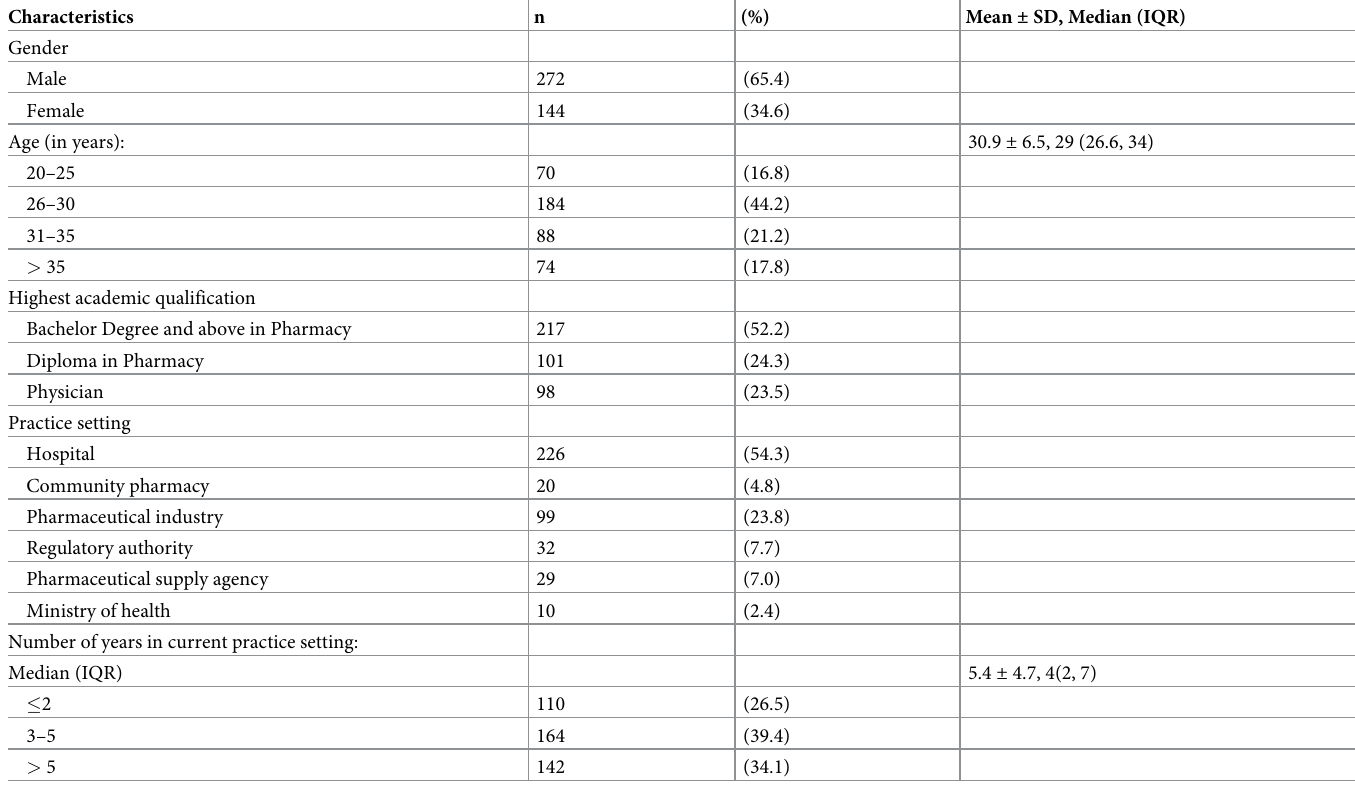
Table 1. Socio-demographic characteristics of health professional participants practicing in Addis Ababa,